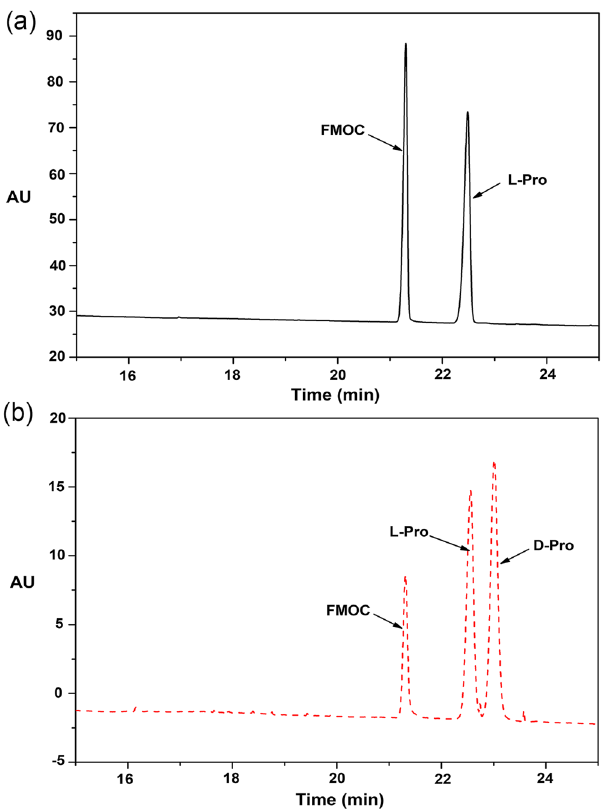
Figure 1. CE analysis of solution of derivatized L-Pro ( a ) and the mixture solution of L-Pro and D-Pro after derivatization ( b ) after 30 min incubation at pH 8.0 at 37